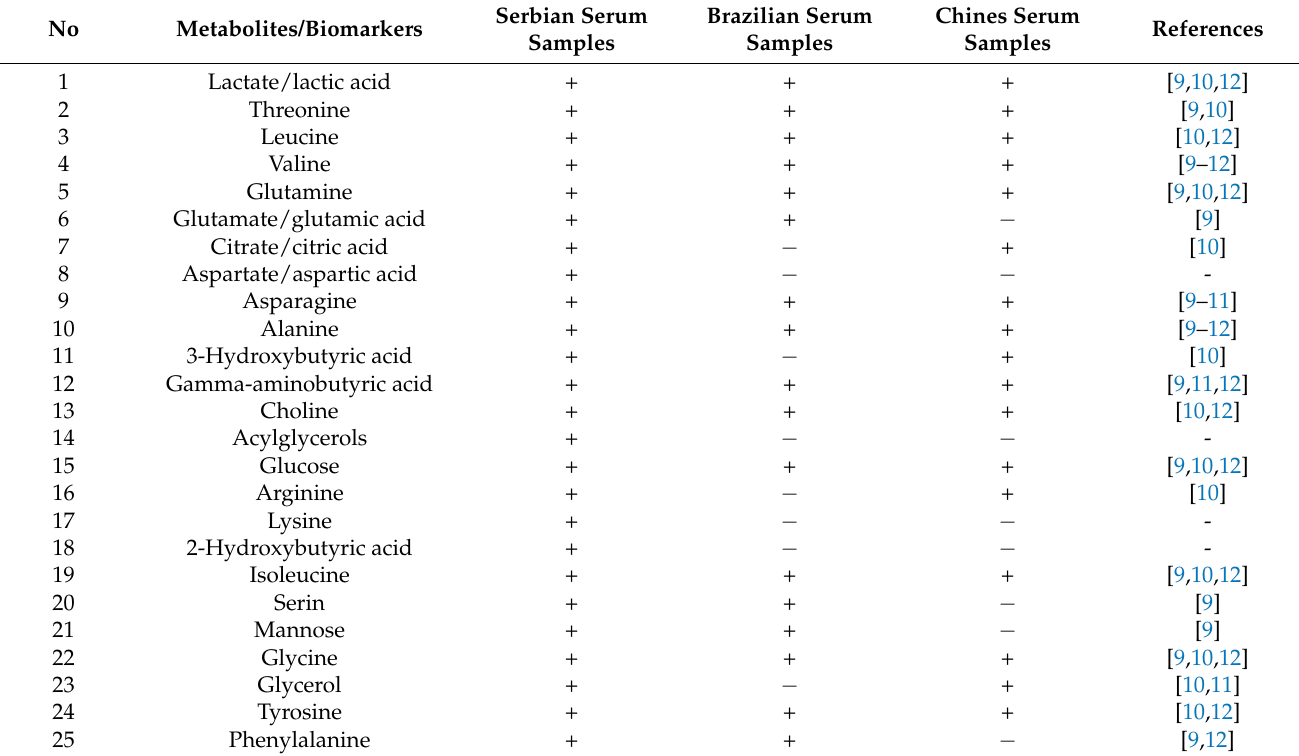
Table 3. Metabolites/biomarkers identified in serum samples of Serbian, Brazilian and Chinese patients with schizophrenia, based on NMR